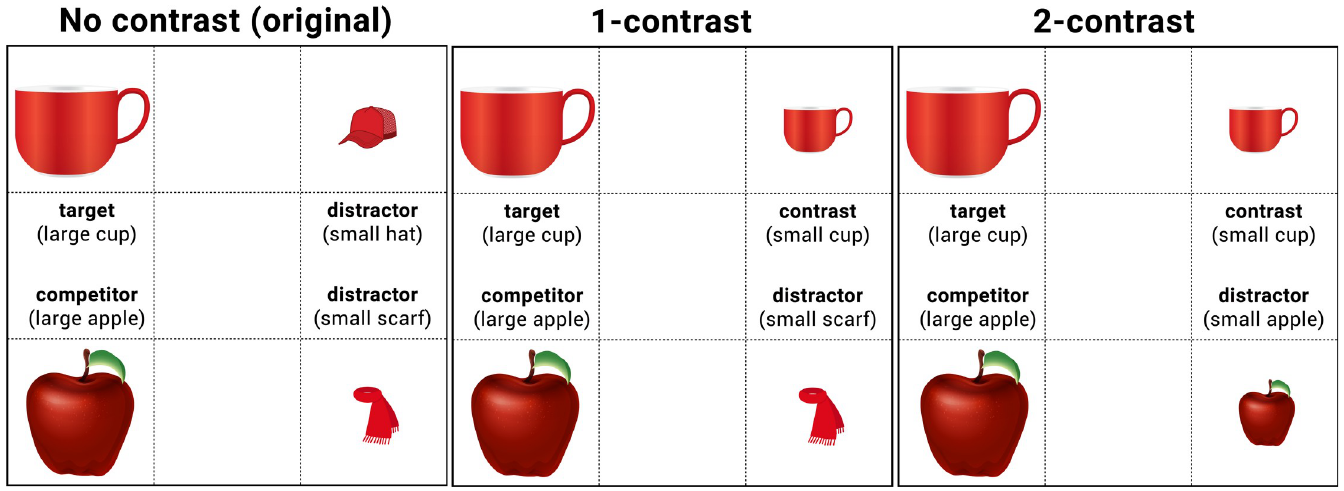
Fig 1. Example displays (no-contrast, 1-contrast vs. 2-contrast conditions) for the instruction, “Click on the large cup”. The no-contrast condition was used in Grodner and Sedivy [18], but replaced with 2-contrast condition in the current experiment. This figure is original, compliant with the CC BY4.0 license, produced by the current study team based on the information provided by Grodner and Sedivy [18]. The images for the 1-contrast and 2-contrast visual displays are also original. They are similar, but not identical, to those that were used in the eye-tracking studies. They are presented here for illustrative purposes only.